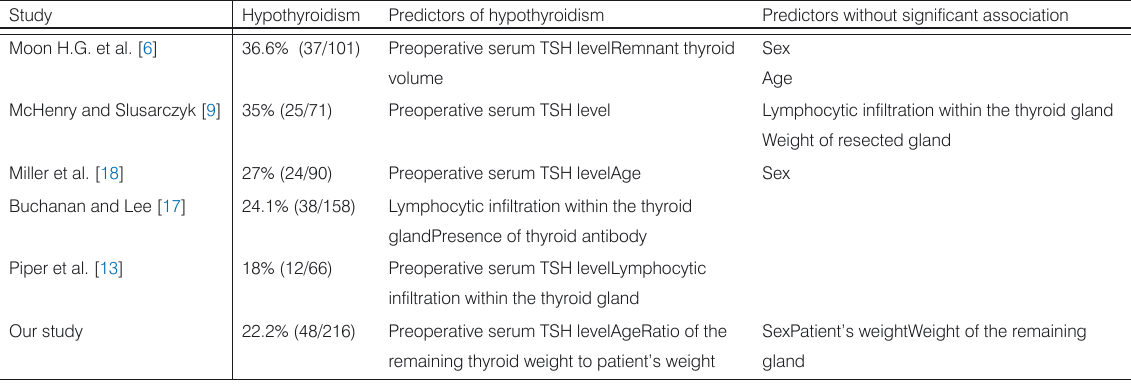
Table 3. Previous studies regarding the predictors of postsurgical hypothyroidism after